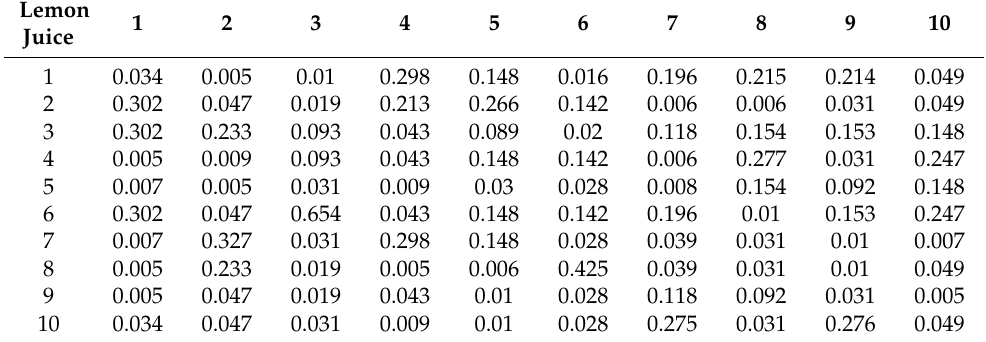
Table A27. Normalization matrix of lemon juice.